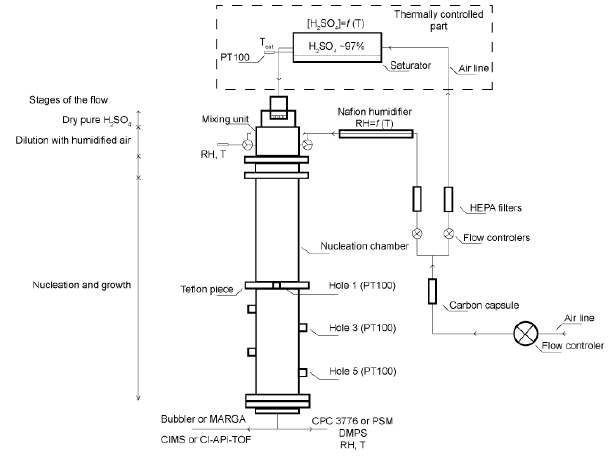
Figure 2. Flow-tube